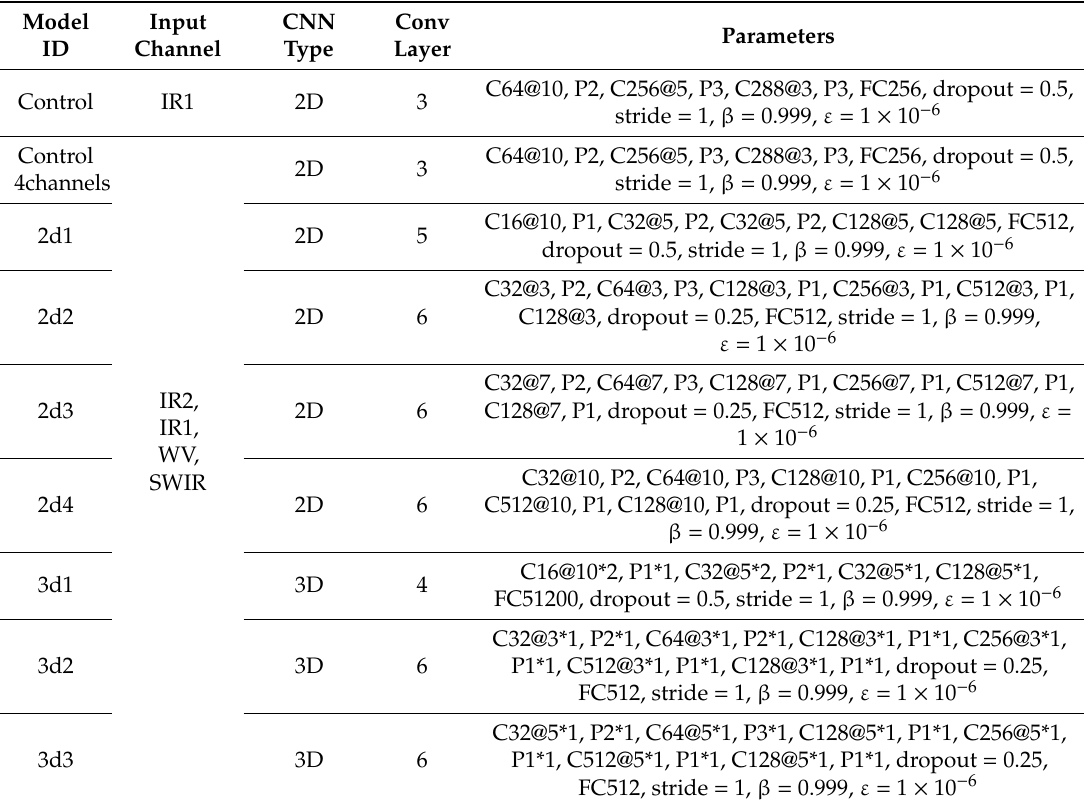
Table 3. Details of CNN model architectures. C, P and FC means a convolutional layer, pooling layer and fully connected layer, respectively. The meaning of the numbers in each abbreviation is as follows; C(# of filters)@(size of filter(horizontal size * vertical size)), P(size of pooling layer (horizontal size * vertical size)). Each convolutional layer has a ReLu activation function and all the models are optimized using Adam optimizer with β = 0.999, ε = 1 × 10 − 6